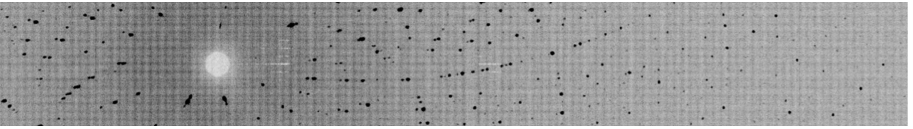
Figure 6 Quasi-Laue projection of time-of-flight neutron diffraction from a crystal of crambin. The detector has been rotated to a 2 (cid:7) angle of 30 (cid:6) to record high-resolution